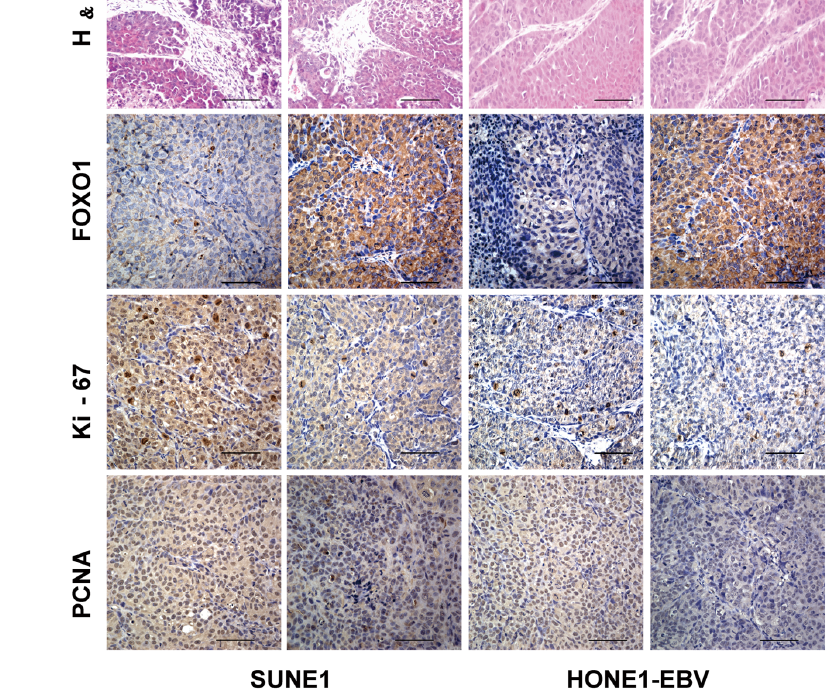
The correct image appears